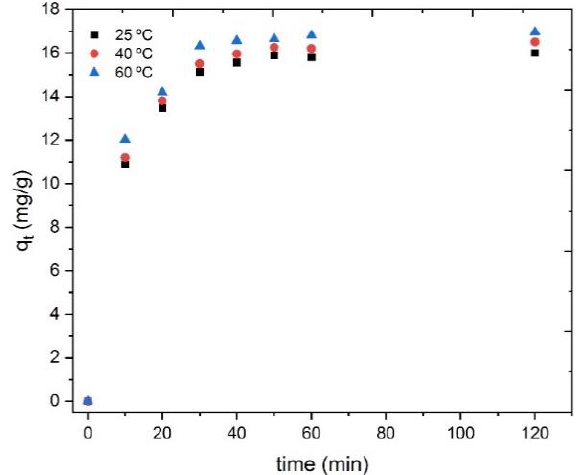
Figure 11. Influence of the temperature on Tb(III) uptake onto the adsorbent at the different times